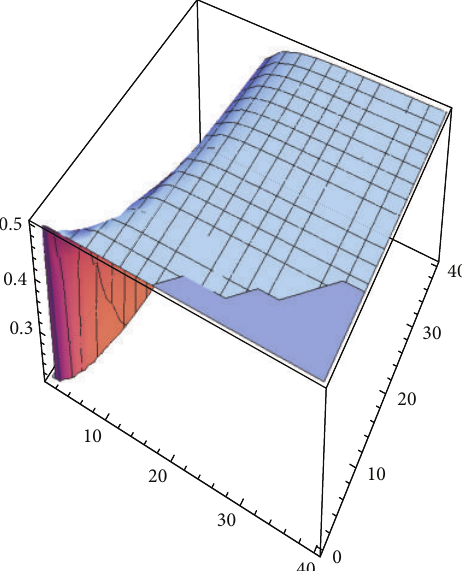
Figure 6: Solution of (30)